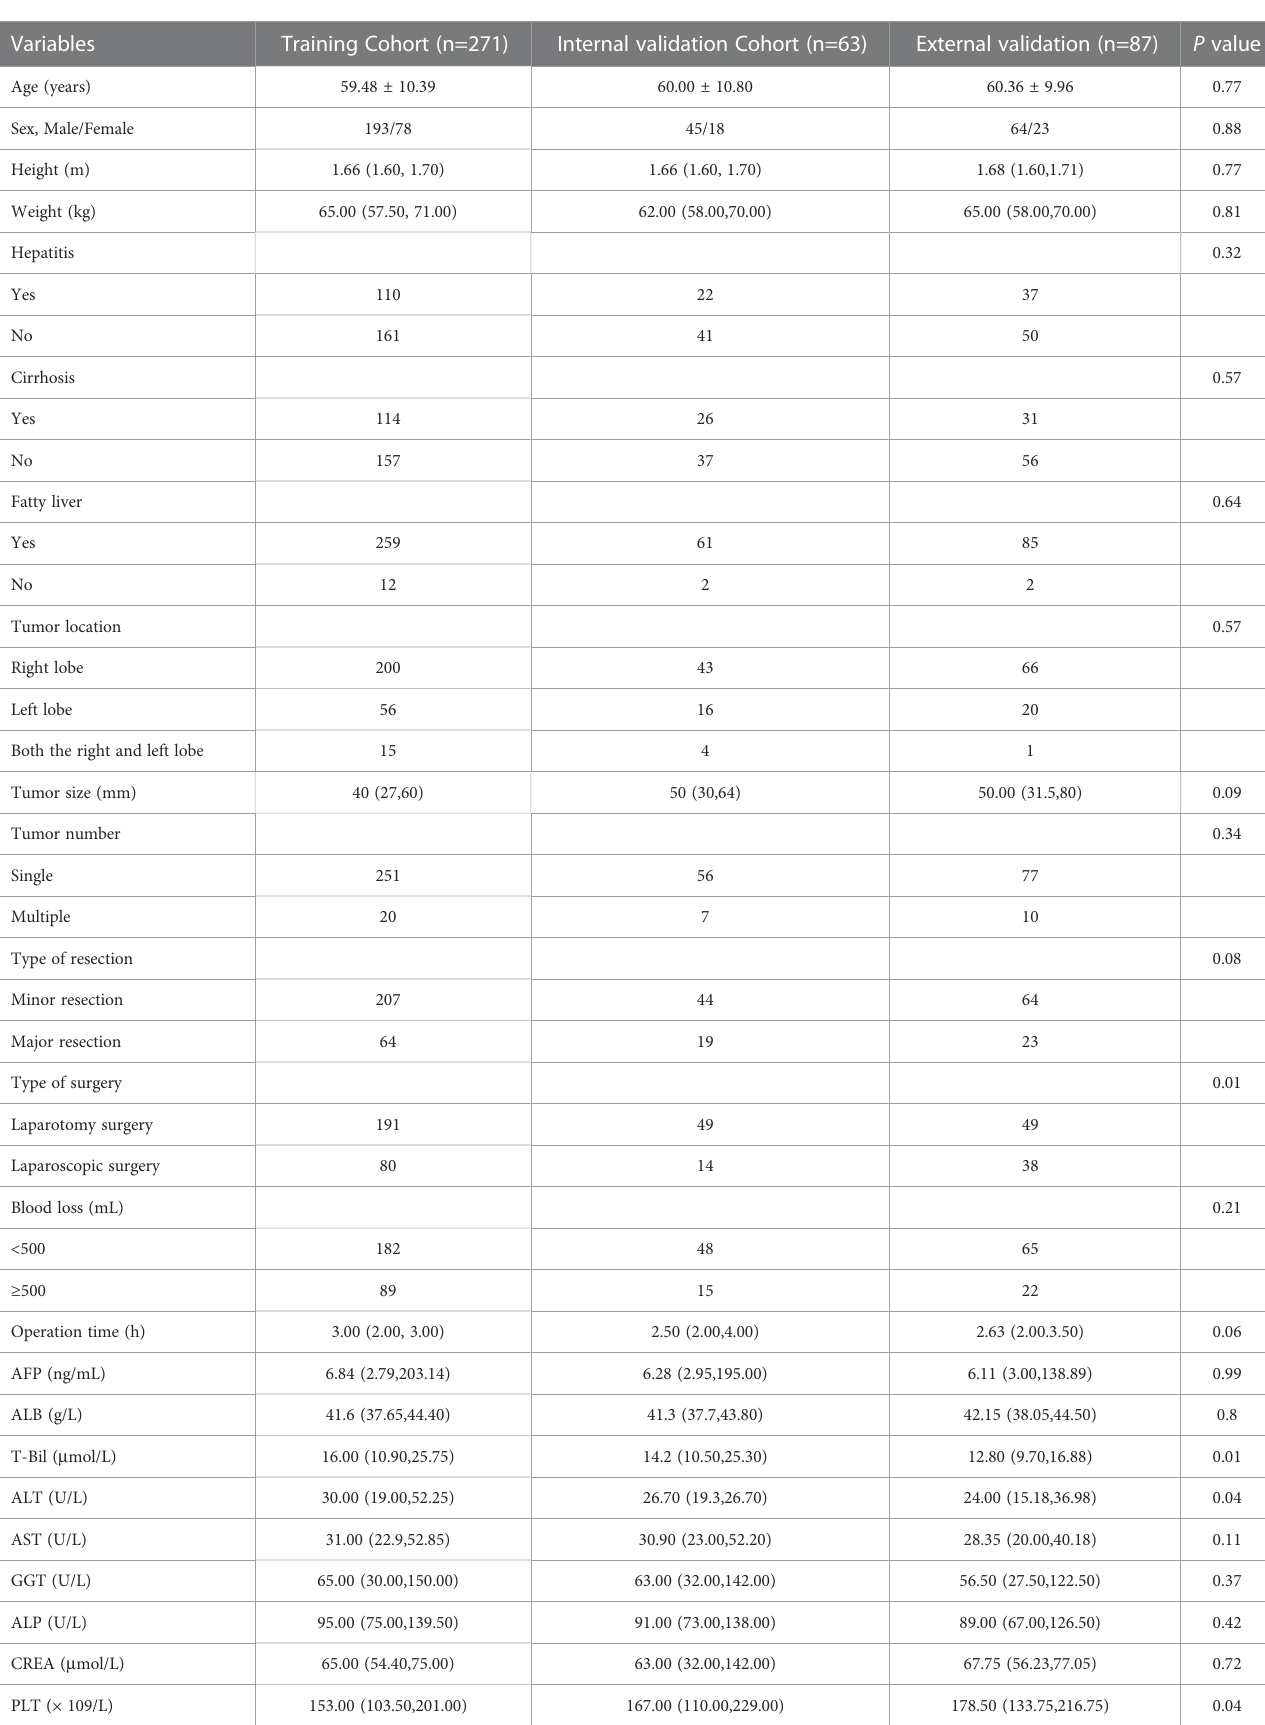
TABLE 1 Clinicopathologic characteristics of study